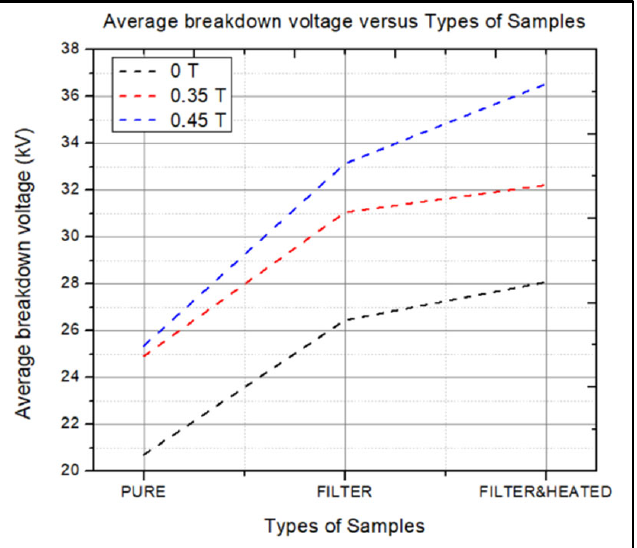
Figure 3. Line graph of AC breakdown voltage without the presence of CNT and different strengths of magnetic fields applied.